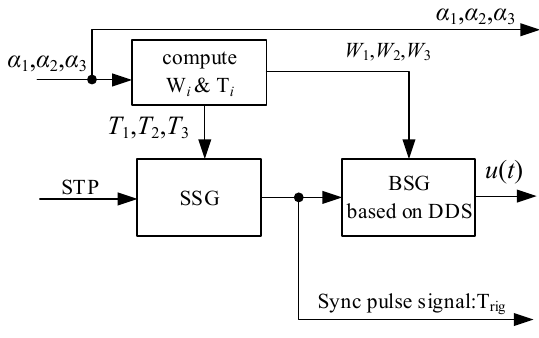
Figure 5. Baseband signal generator block